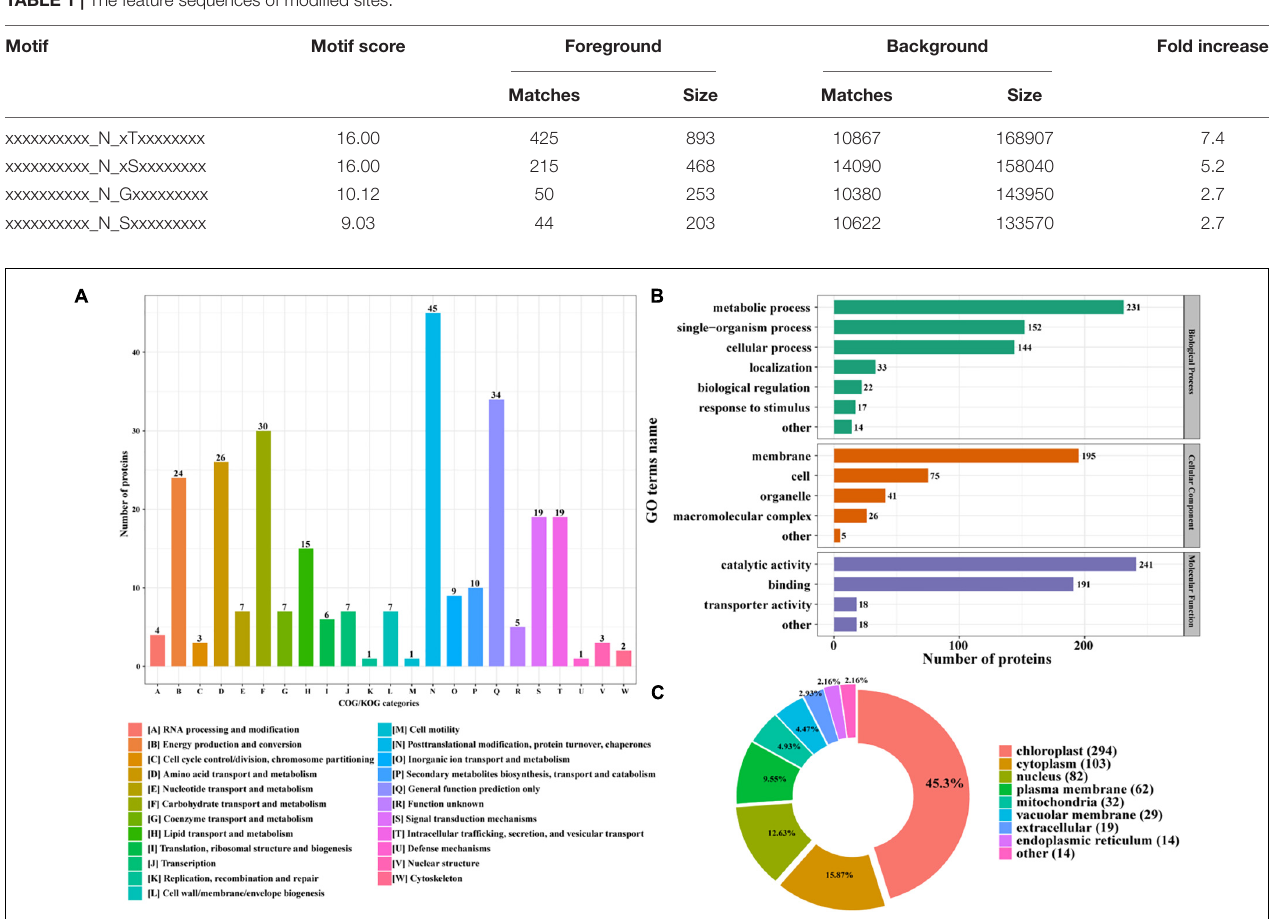
TABLE 1 | The feature sequences of modified sites.